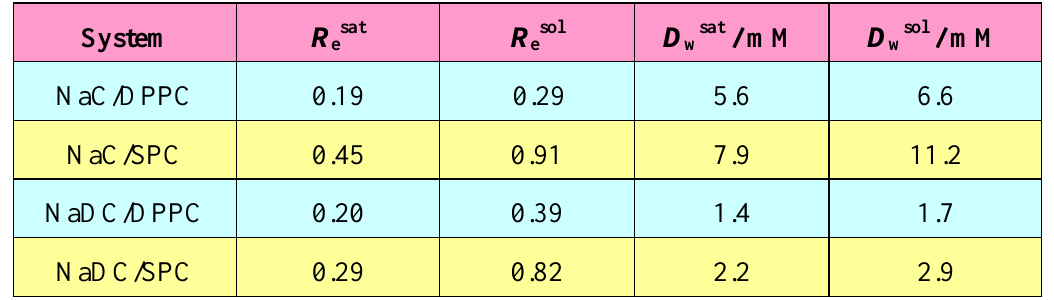
Table 4. NaC and NaDC solubilisation data for DPPC and SPC in 100 mM NaCl ( pH 7.5) at 60 °C. R : slopes of the saturation (sat) and e solubilisation (sol) process, D : equilibrium bile salt w